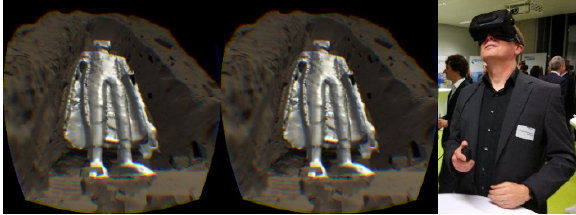
Figure 5. Stereoscopic rendering as shown via a head mounted device (HMD – Oculus Rift DK 2)